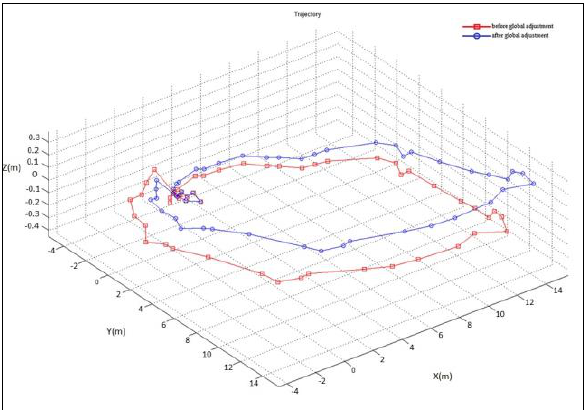
Figure 3. The trajectory of sensor poses maintained before and after